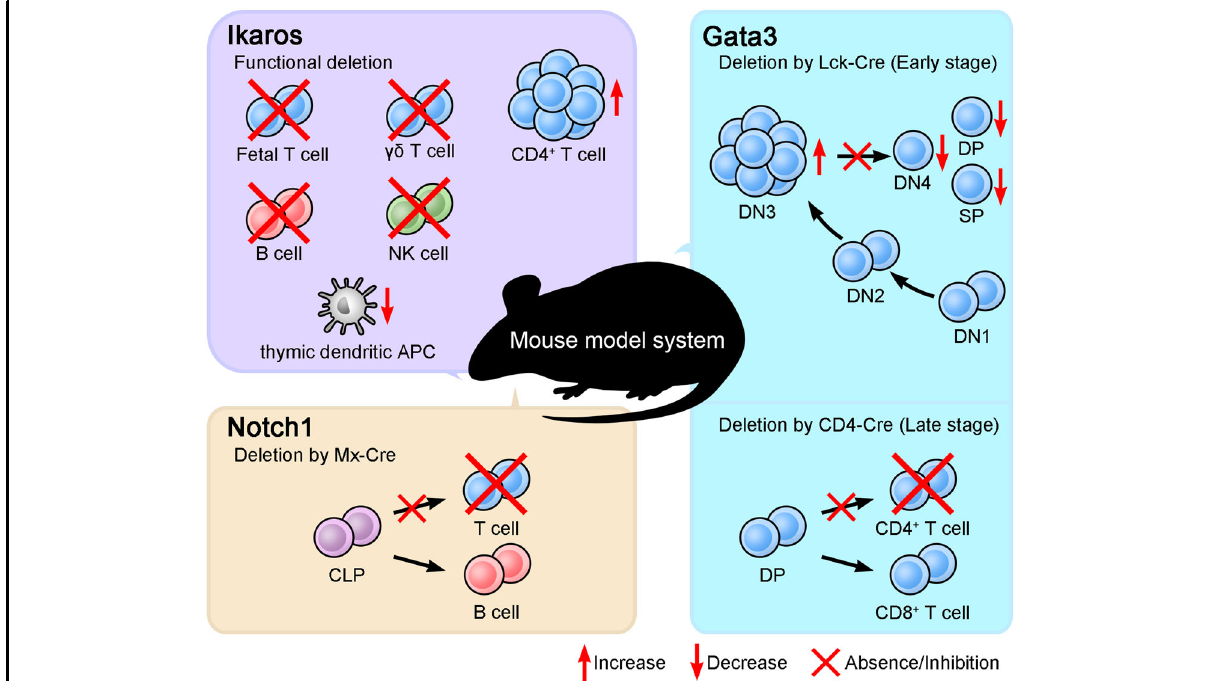
Fig. 2 Transcriptional controls of T cell development. CLP common lymphoid progenitor, DN double negative, DP double